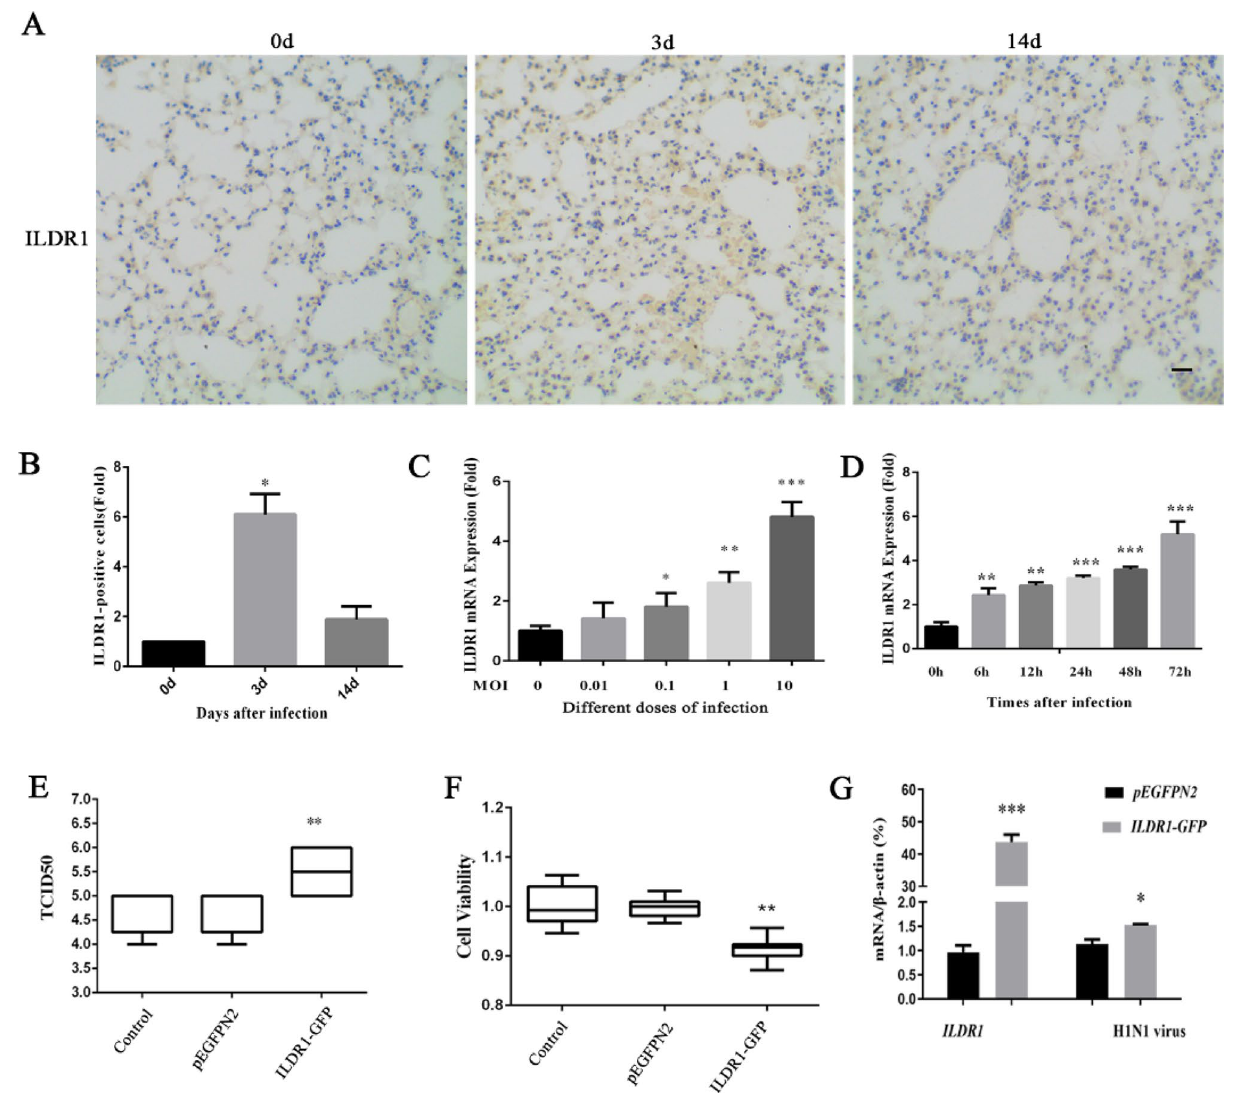
Figure 5. ILDR1 Expression after swine influenza virus infection. ( A ) C57BL/6 J mice were infected intranasally with 10 3 pfu. SIV. The lungs of mice were taken after infection 0, 3 and14 days for immunohistochemical detection. ILDR1 was detected by immunohistology using rabbit anti-ILDR1, visualized with 3,3,-diaminobenzidine and counterstained with hematoxylin. Scale bar: 20 μm. The expression levels of the ILDR1 after infection relative to that of normal expression were analyzed by areal density ( B ). ( C ) HEK 293 T cells were infected with different doses(MOI = 0,0.01,0.1,1,10) for 48 h, and RNA were extracted, then the expression of ILDR1 was confirmed by quantitative reverse-transcription PCR. Data represent the mean value ± SD. Asterisks indicate statistical difference (n = 3, Unpaired t test; * P < 0.05, ** P < 0.01, *** P < 0.001). ( D ) Expression of ILDR1 in virus-infected cells at an MOI of 0.1. RNA were extracted at different time points (0 h, 6 h, 12 h, 24 h, 48 h) and subjected to RT-qPCR. Data represent the mean value ± SD. Asterisks indicate statistical difference (n = 3, Unpaired t test; * P < 0.05, ** P < 0.01, *** P < 0.001). ( E ) Virus replication in ILDR1- overexpressing HEK293T cells. Cells were transfected with ILDR1-GFP or pEGFPN2 for 24 h, and then infected with SIV at an MOI of 0.1. RNA were extracted at the indicated time points, and virus titers or NP expression were determined by TCID50, CCK-8 ( F ) and RT-qPCR ( G indeed more susceptible to SIV. By examining the survival rate, body weight and lung virus load of the mice, we presented in vivo evidence for the first time that PLSCR1 is important for inhibiting influenza virus replication, which was consistent with the report of PLSCR1 negatively regulates virus replication by interacting with NP in the cytoplasm and preventing its nuclear import in vitro 20 . We also found that PLSCR1 is widely distributed in various tissues of mice (except heart and brain). Among these, PLSCR1 is highly expressed in the lung, the target organ of influenza virus. At the same time, we observed the higher bands of PLSCR1 in the cerebrum and cerebellum (approximately 55 kD) were initially detected, then we tested the expression of PLSCR1 in wild mice and Plscr1 −/− mice by western blot, and found that this band still exists, so it is speculated that it may be a non-specific band. This results have also been verified by Sahu SK in human tissue 31 .